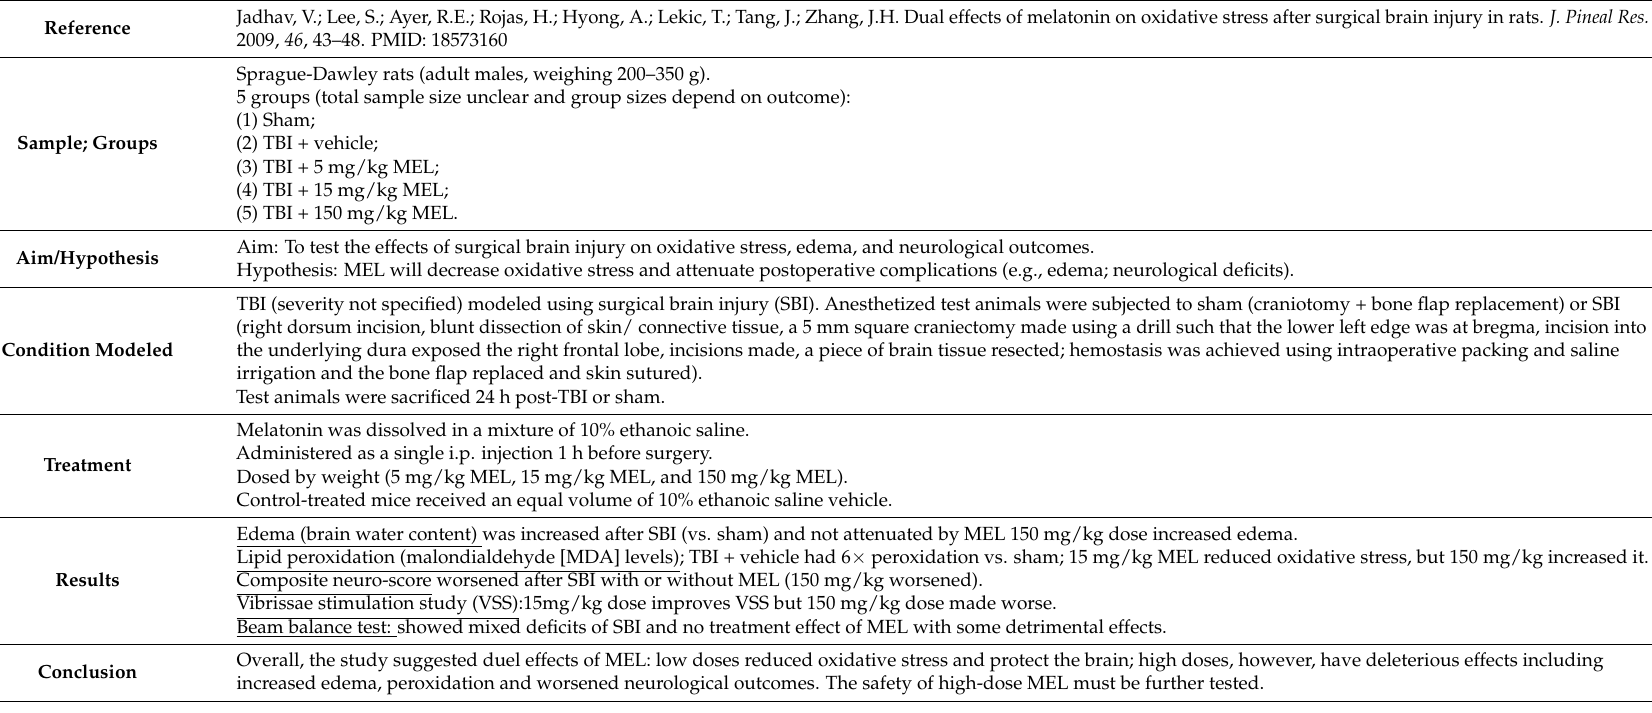
Table A9. Jadha et al. (2009) Study